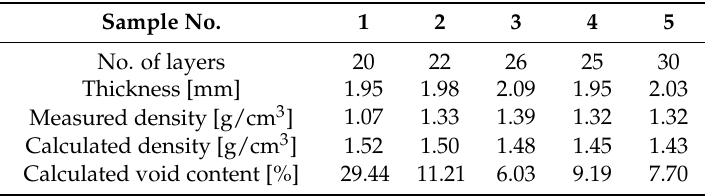
Table 3. Number of layers and the thickness (mm) of the samples produced. Their measured and calculated densities along with the calculated void content are also displayed. Sample